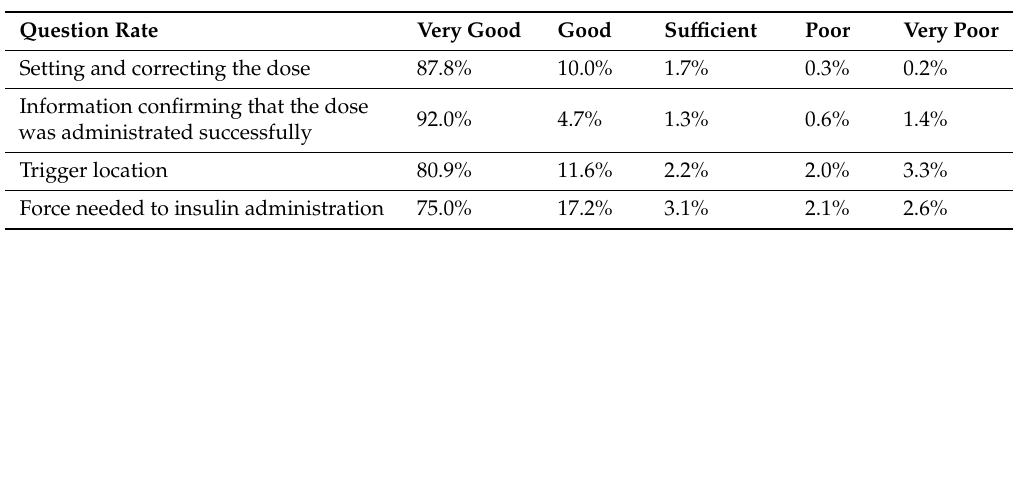
Table 2. The questionnaire surveyed at telephone contact assessing the GensuPen use among all study participants ( n =